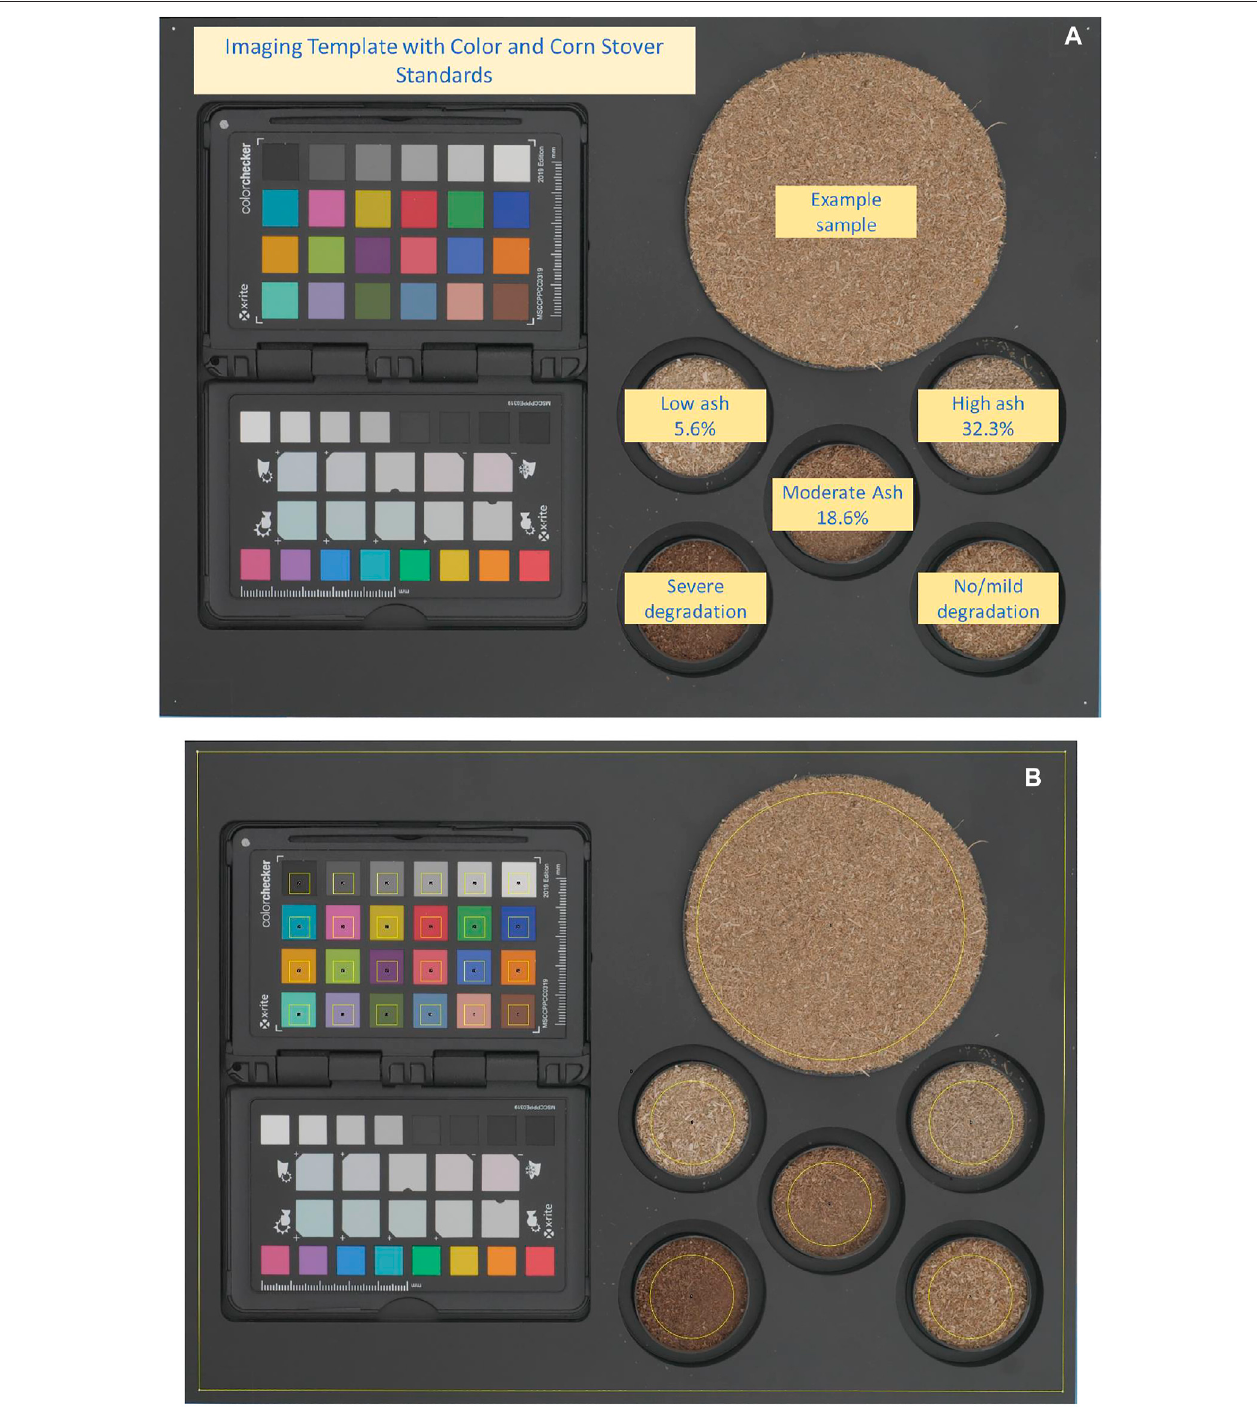
FIGURE 1 | (A) Image work fl ow sample template with internal color standards and biomass samples; (B) Examples of the region of interest selection to measure and output RGB channel data.